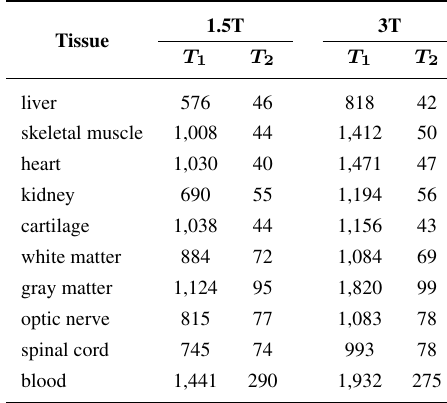
Table 3. Mean spin-lattice and spin-spin relaxation times for the considered tissues at 1.5 T and 3 T.